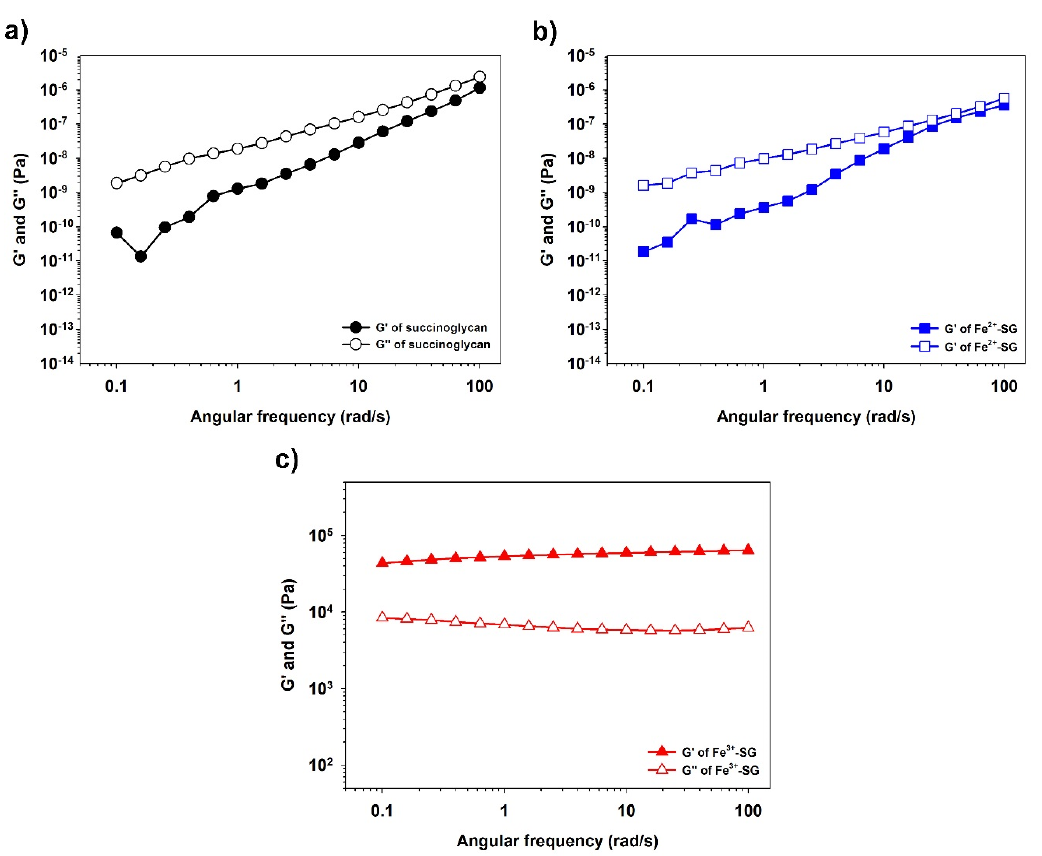
Figure 2. The rheological analysis of succinoglycan ( a ), Fe 2+ -coordinated succinoglycan (Fe 2+ -SG) sol ( b ), and Fe 3+ -SG hydrogel ( c ).